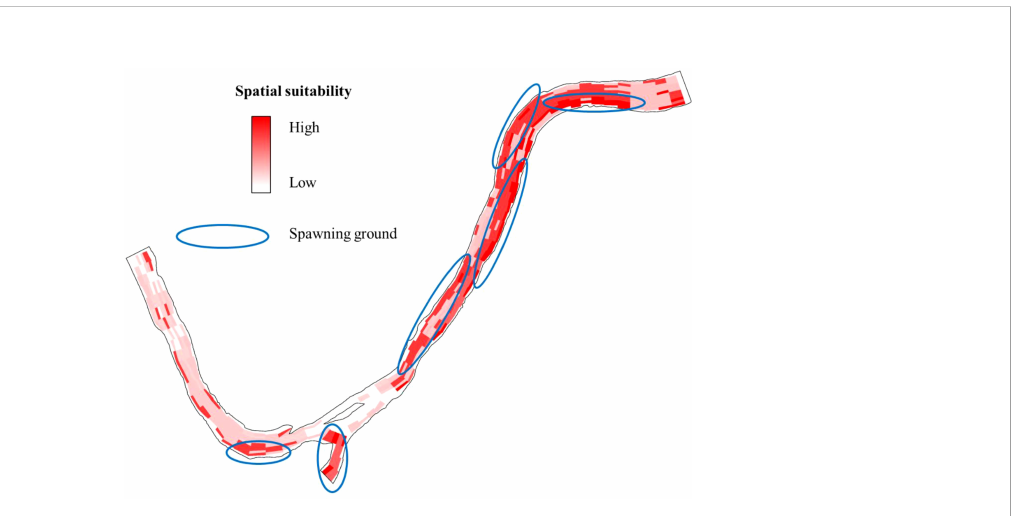
FIGURE 11 Spatial suitability distribution map of Asian carp spawning